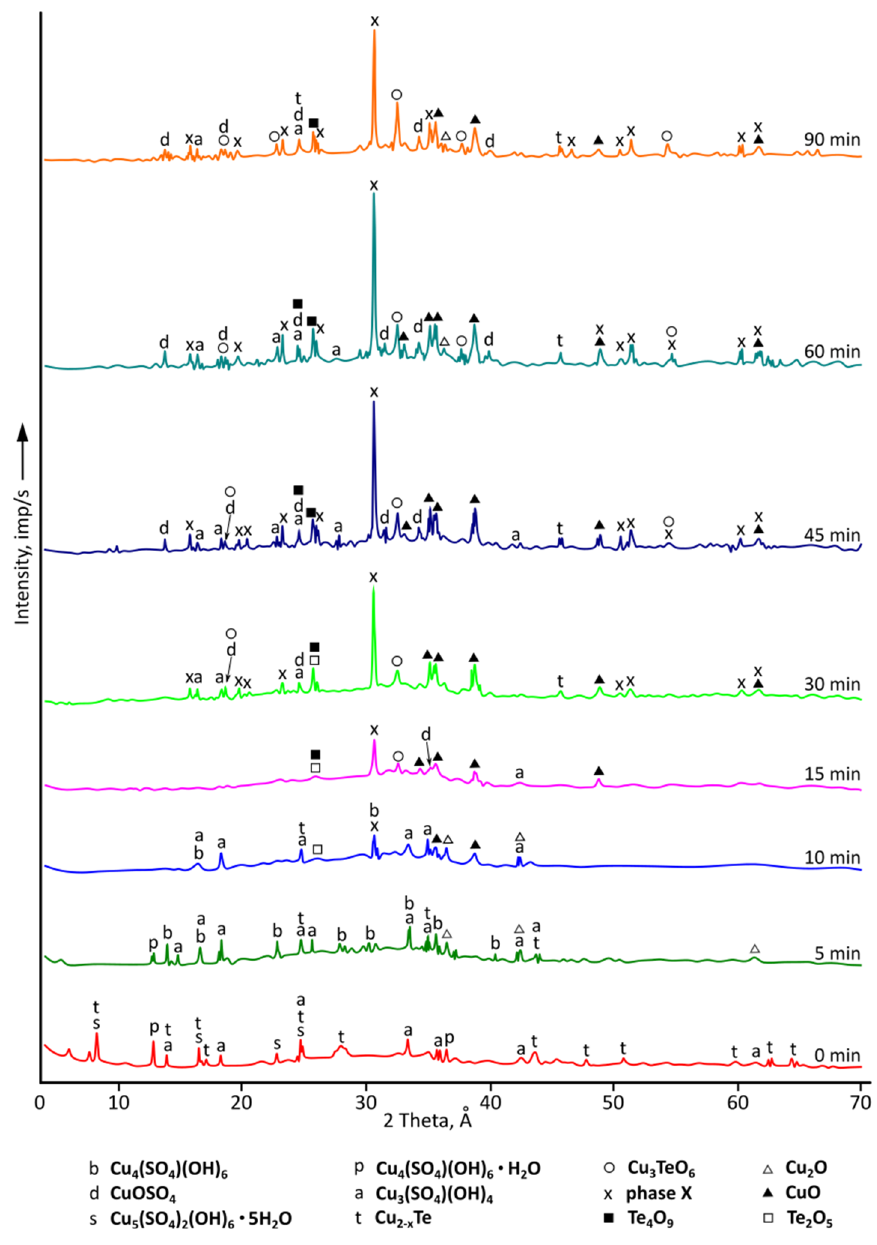
Figure 4. X-ray patterns of residues were obtained at 500 °C, 0.67 kPa, and different roasting durations.